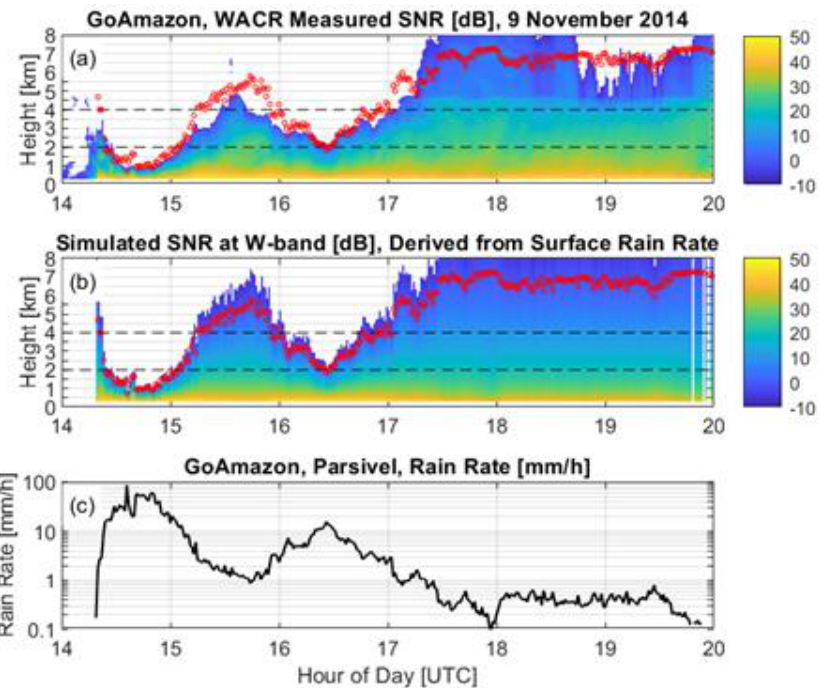
Figure 9. Time-height cross-section of W-band SNR. ( a ) Measured WACR 𝑆𝑁𝑅 [dB] on 9 November 2014, ( b ) simulated SNR [dB] derived from surface rain rate (see Equations (11) and (14)). The two black dashed lines at 4 and 2 km are visual aids to facilitate comparing panels. Red circles correspond to the height where the simulated SNR in ( b ) is 0 dB. ( c ) Surface disdrometer rain rate used to construct simulated SNR profiles in ( b ).